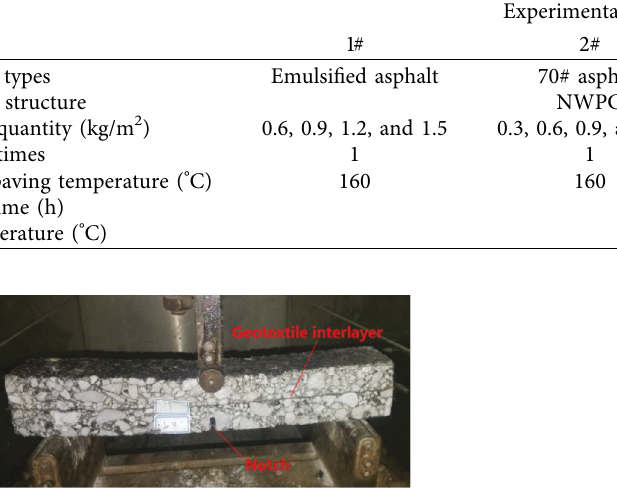
Figure 5: Fatigue bending test for the composite beam with the notch.